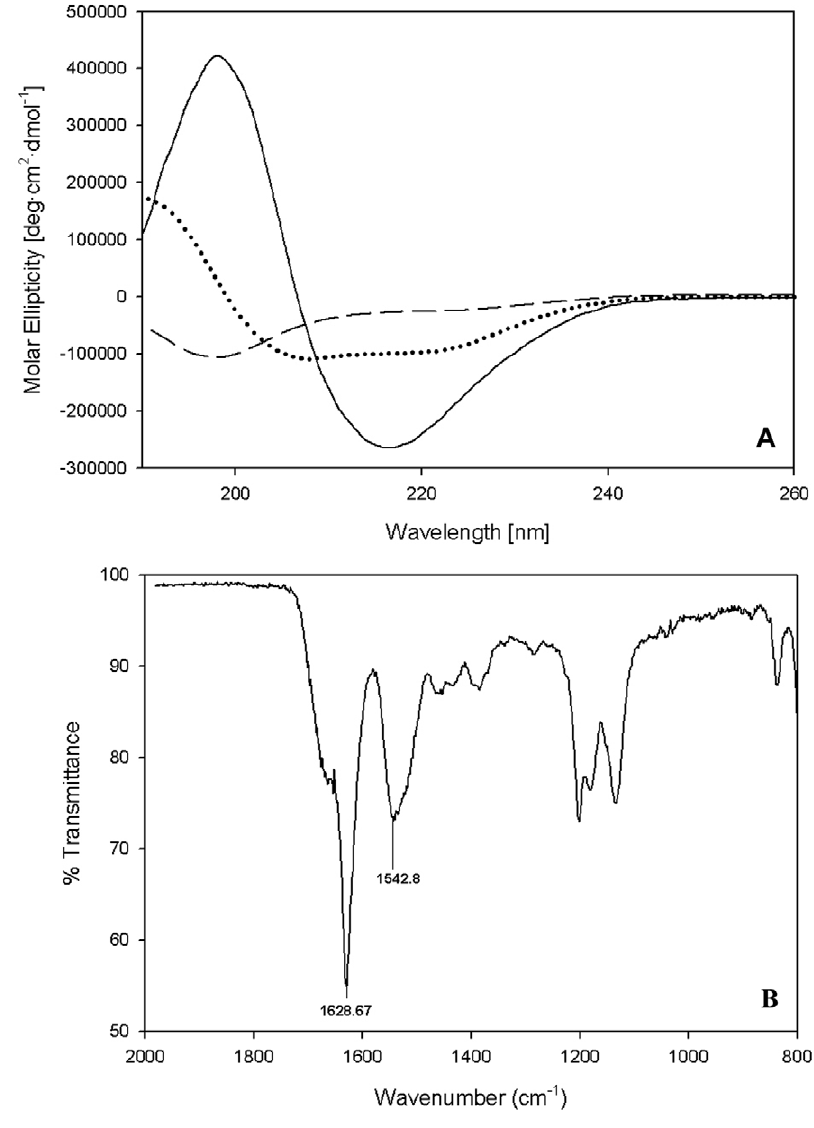
Figure 6. Secondary Structural Characterizations. (A) Circular dichroism (CD) spectroscopy shows that the h 9 h 5 -vesicles adopt a b -structure (solid line) at pH 7.0 in 5 mM NaHCO 3 , a helical structure (dotted line) in 40% TFE and remains unstructured (dashed line) when lacking the lysine branch point (h 9 -K 5 ). (B) FTIR spectroscopy of dried material shows the characteristic 1629 cm 2 1 maximum corresponding to b - secondary structure.